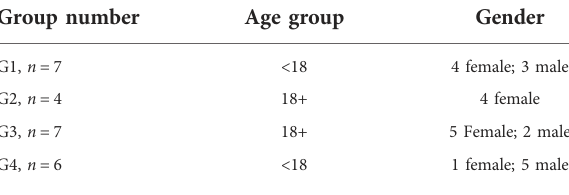
TABLE 1 Summary of demographics for the four participant groups, N =24. Group